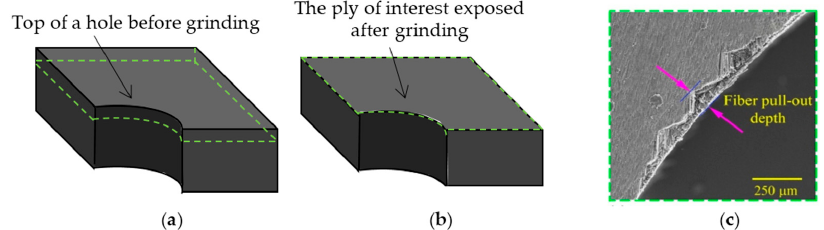
Figure 4. Destructive method of the fiber pull-out depth measurement process; ( a ) as-machined CFRP hole (the dotted line indicate the ply of interest); ( b ) a ground CFRP hole after grinding; and ( c ) a top view of the fiber pull-outs on the ground and polished CFRP hole observed in SEM.